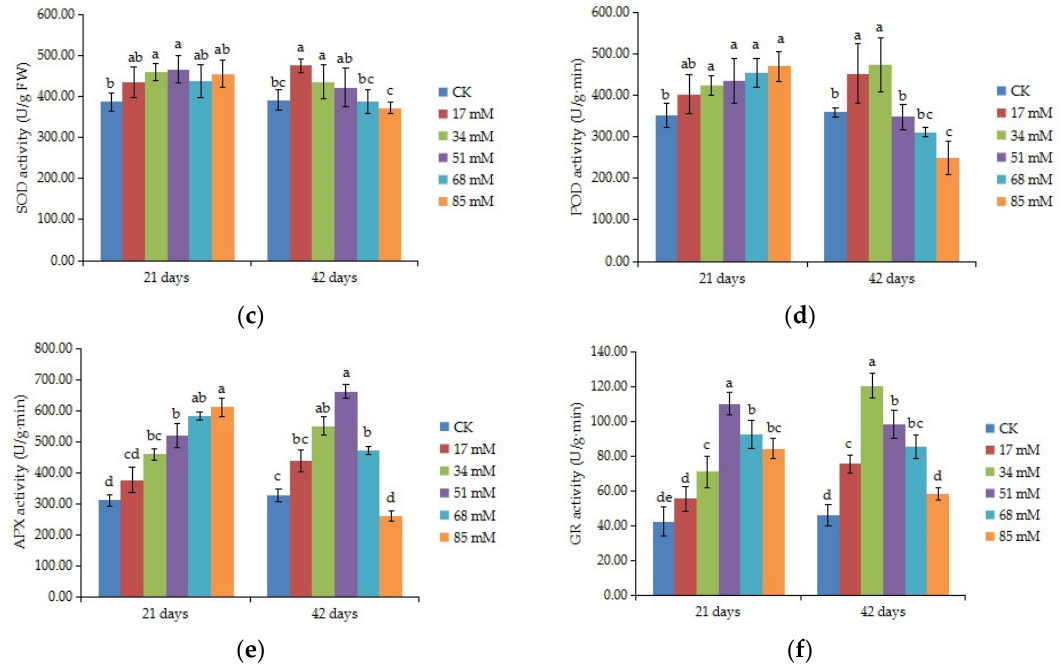
Figure 4. Effects of increasing levels of soil salinity on the MDA content ( a ), cell membrane stability ( b ), SOD activity ( c ), POD activity ( d ), APX ( e ), and GR ( f ) in leaves of C. turczaninowii grown for 21 and 42 days. Different lowercase letters indicate significant differences among treatments ( p < 0.05), n = 3.